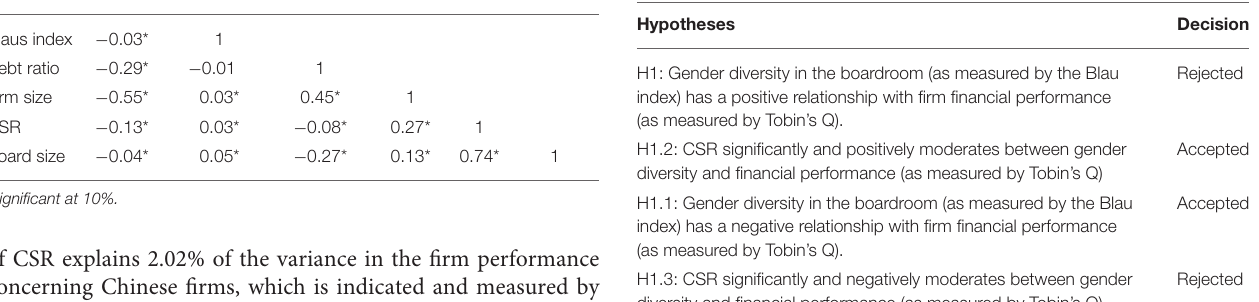
TABLE 5 | Spearmen’s matrix.